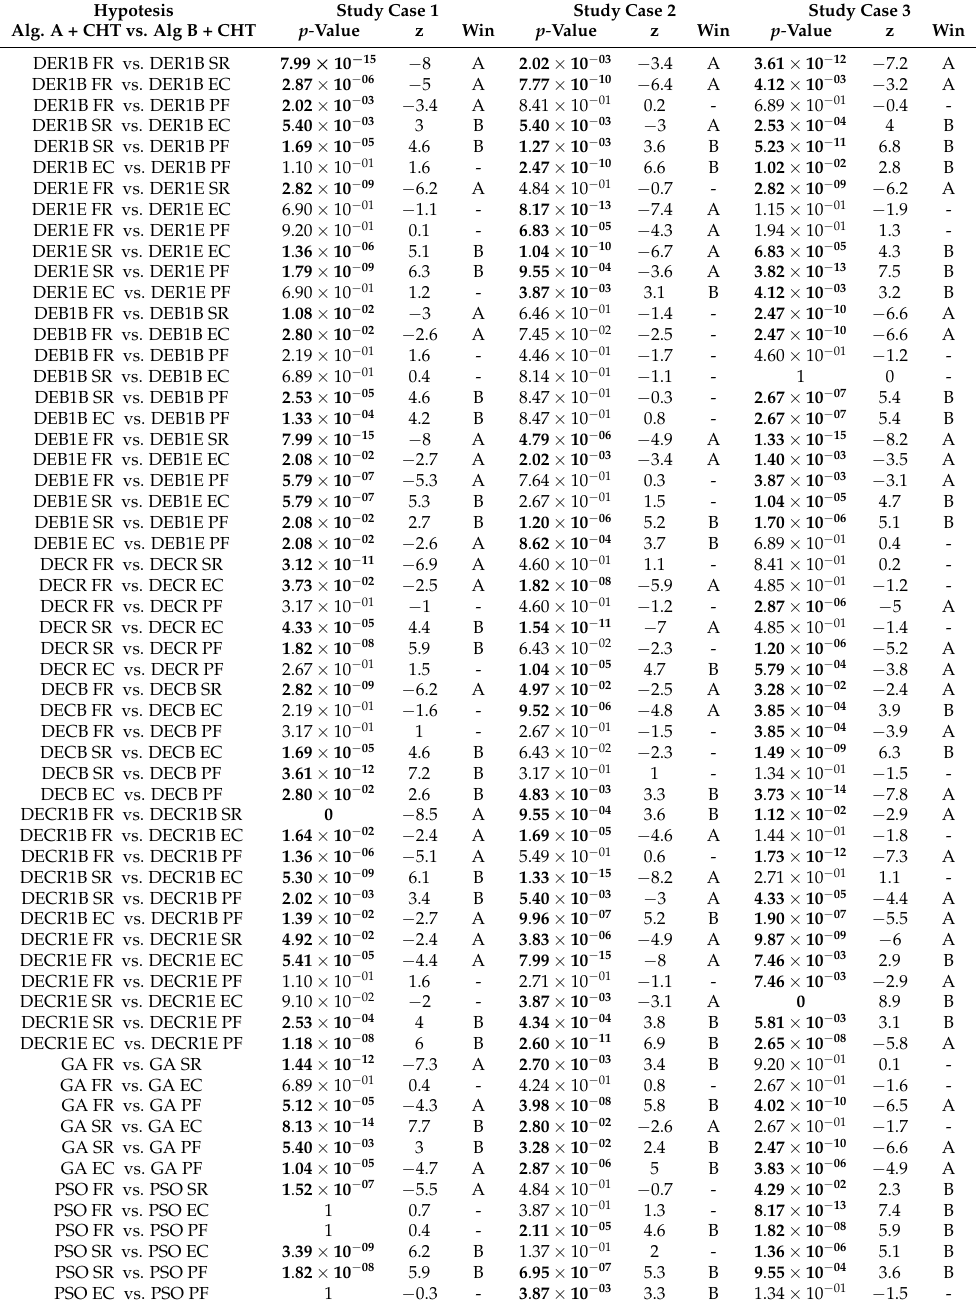
Table A11. Multiple comparison Friedman test with the post-hoc correction method for the overall performance of the four CHTs included into the ten metaheuristic algorithms. “-” indicates that there is no winning